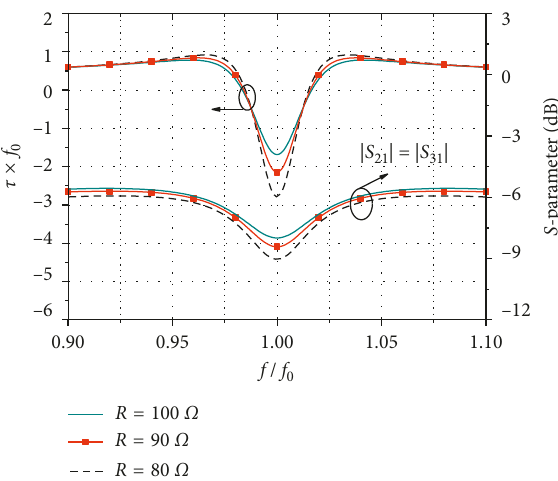
Figure 3: Effect of R on the IL and τ × f power